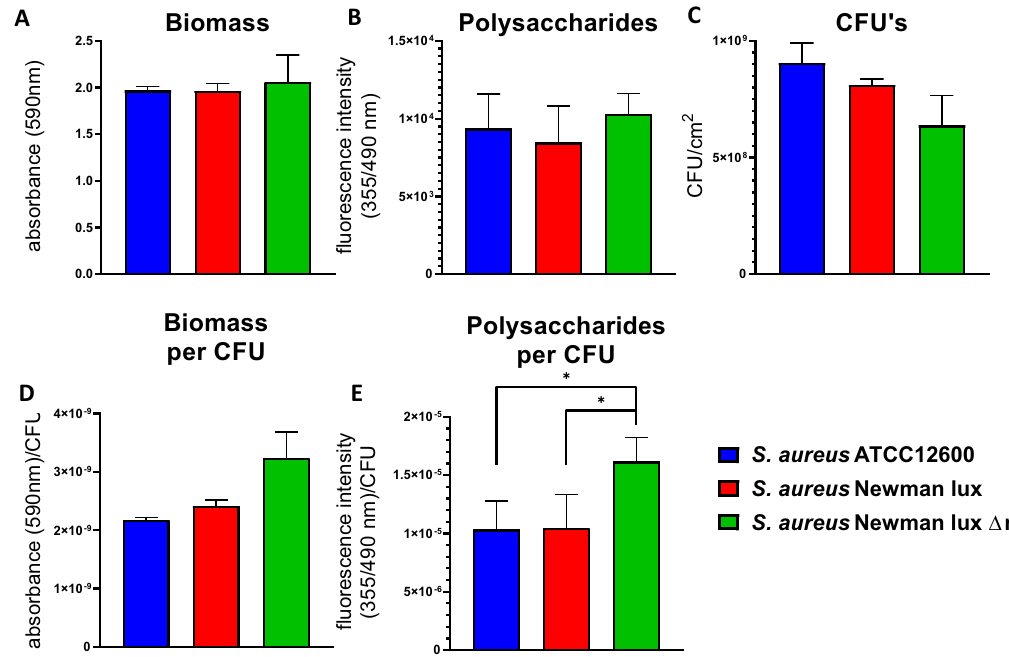
Figure 1. Biofilm characteristics of S. aureus ATCC12600, Newman lux, and Newman lux Δ nuc1 . ( A ) Biomass of biofilms measured by spectral absorption after crystal violet staining. ( B ) Polysaccharide content of biofilms measured by fluorescent intensity after calcofluor white staining ( C ) Colony forming units (CFU’s) per cm 2 of biofilms grown for 24 h in a 24 wells plate. ( D ) Ratios of biomass/CFU and ( E ) polysaccharides/CFU of biofilms. All data shown are averages of triplicate measurements in three separate cultures, repeated on separate days. Error bars indicate standard error of the mean. Statistical differences were calculated using an ANOVA. *Significant difference (p < 0.05). In ( D , E ) the natural logarithm of the values was used for statistical analysis as the data are lognormally distributed (see also Fig. S3).